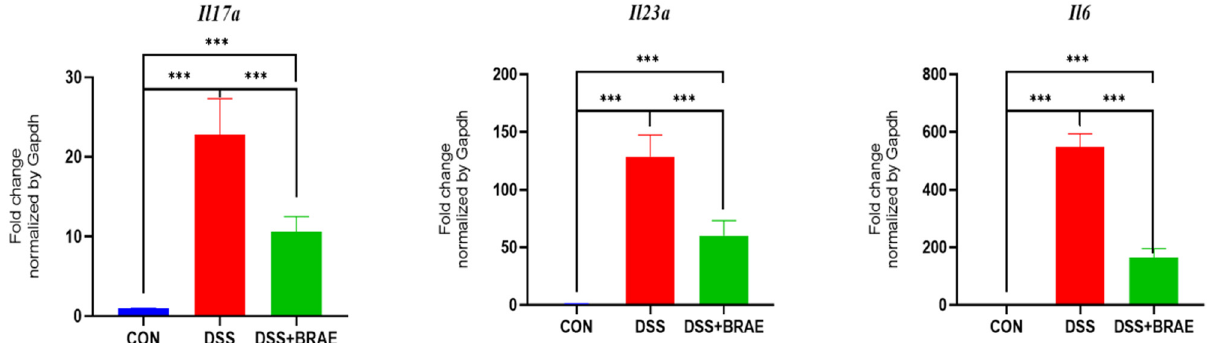
Figure 7: BRAE alleviates colonic in fl ammation gene expression in DSS - induced colitis